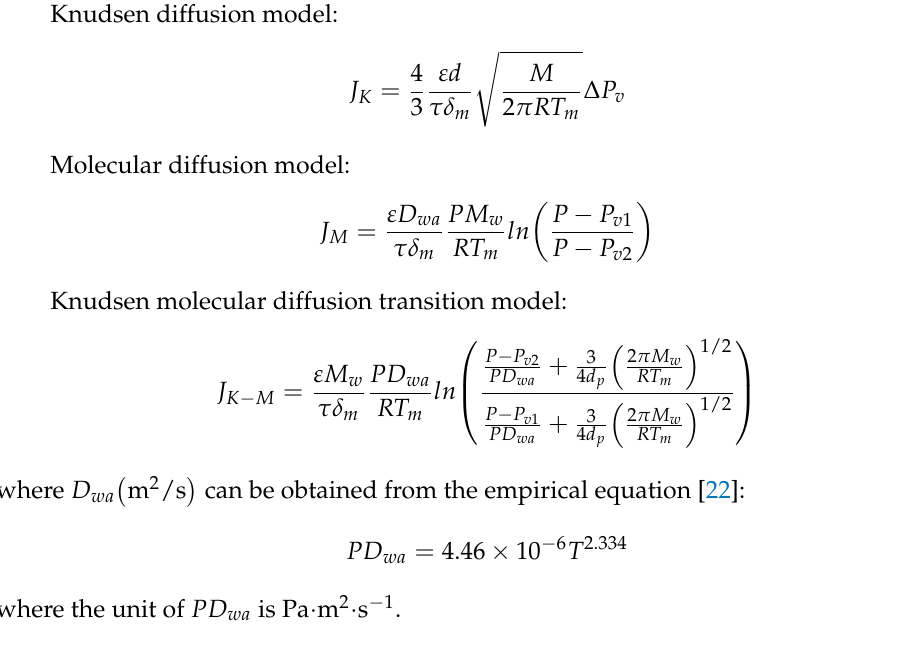
Figure 2. Mass transfer resistances in MD.